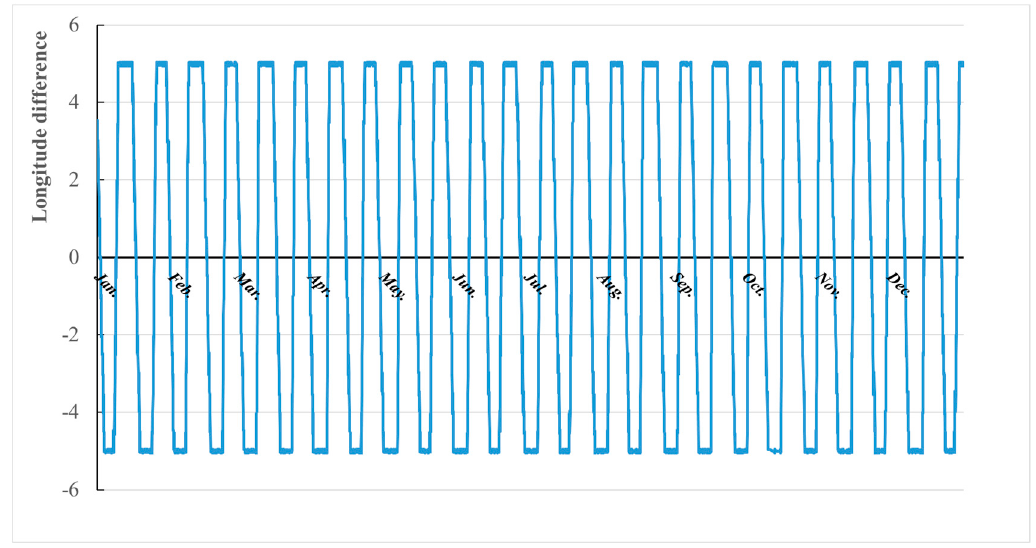
Figure 8. Longitude difference between extreme point of earth’s tidal displacement and lunar subpoint in 8760 phases in 2018.